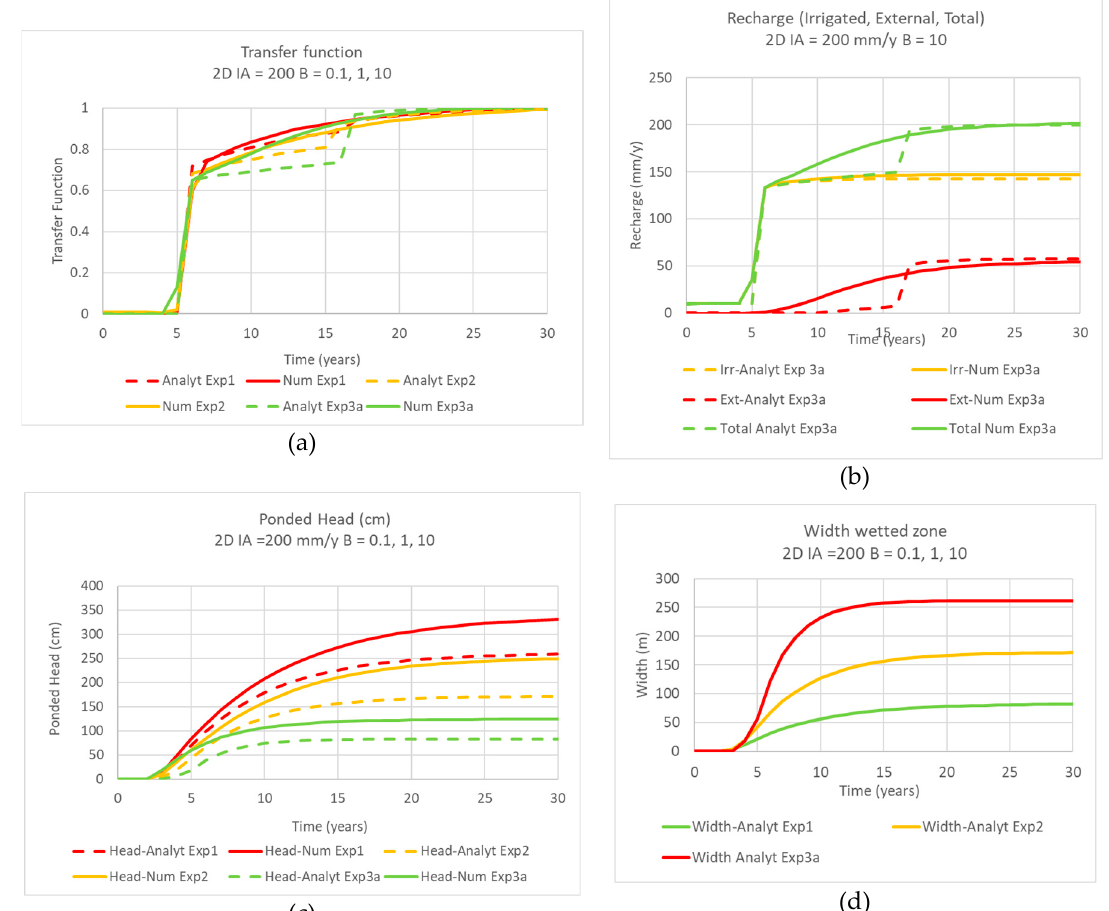
Figure 5. Comparison of outputs from two-dimensional semi-analytical and numerical modelling for new accession rate of 200 mm/year: ( a ) Transfer functions (Total) for B = 0.1, 1, 10; ( b ) Transfer functions (total, under irrigation field, external to irrigation field) for B = 10. ( c ) Perched heads for B = 0.1, 1.0, 10 for an increase in IA to 200 mm/year. The head for the FEFLOW model is for x = 0, while that for PerTy3 is an average across the irrigated field. ( d ) the width of the wetted zone outside the irrigation field for B = 0.1, 1.0, 10, and an increase in IA to 200 mm/year.